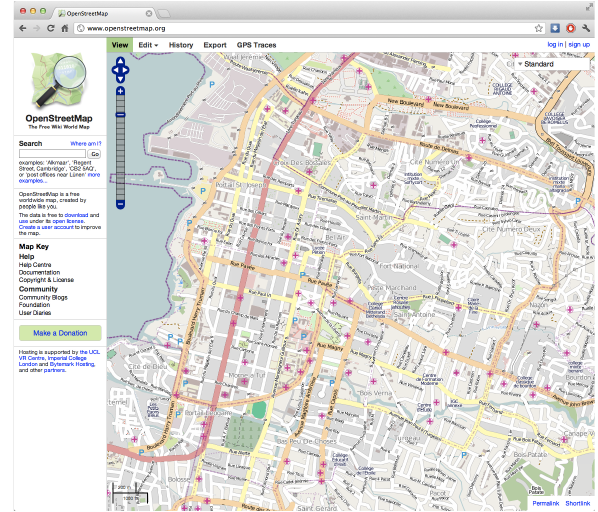
Figure 5. OSM Map of Port-au-Prince as of 20 April